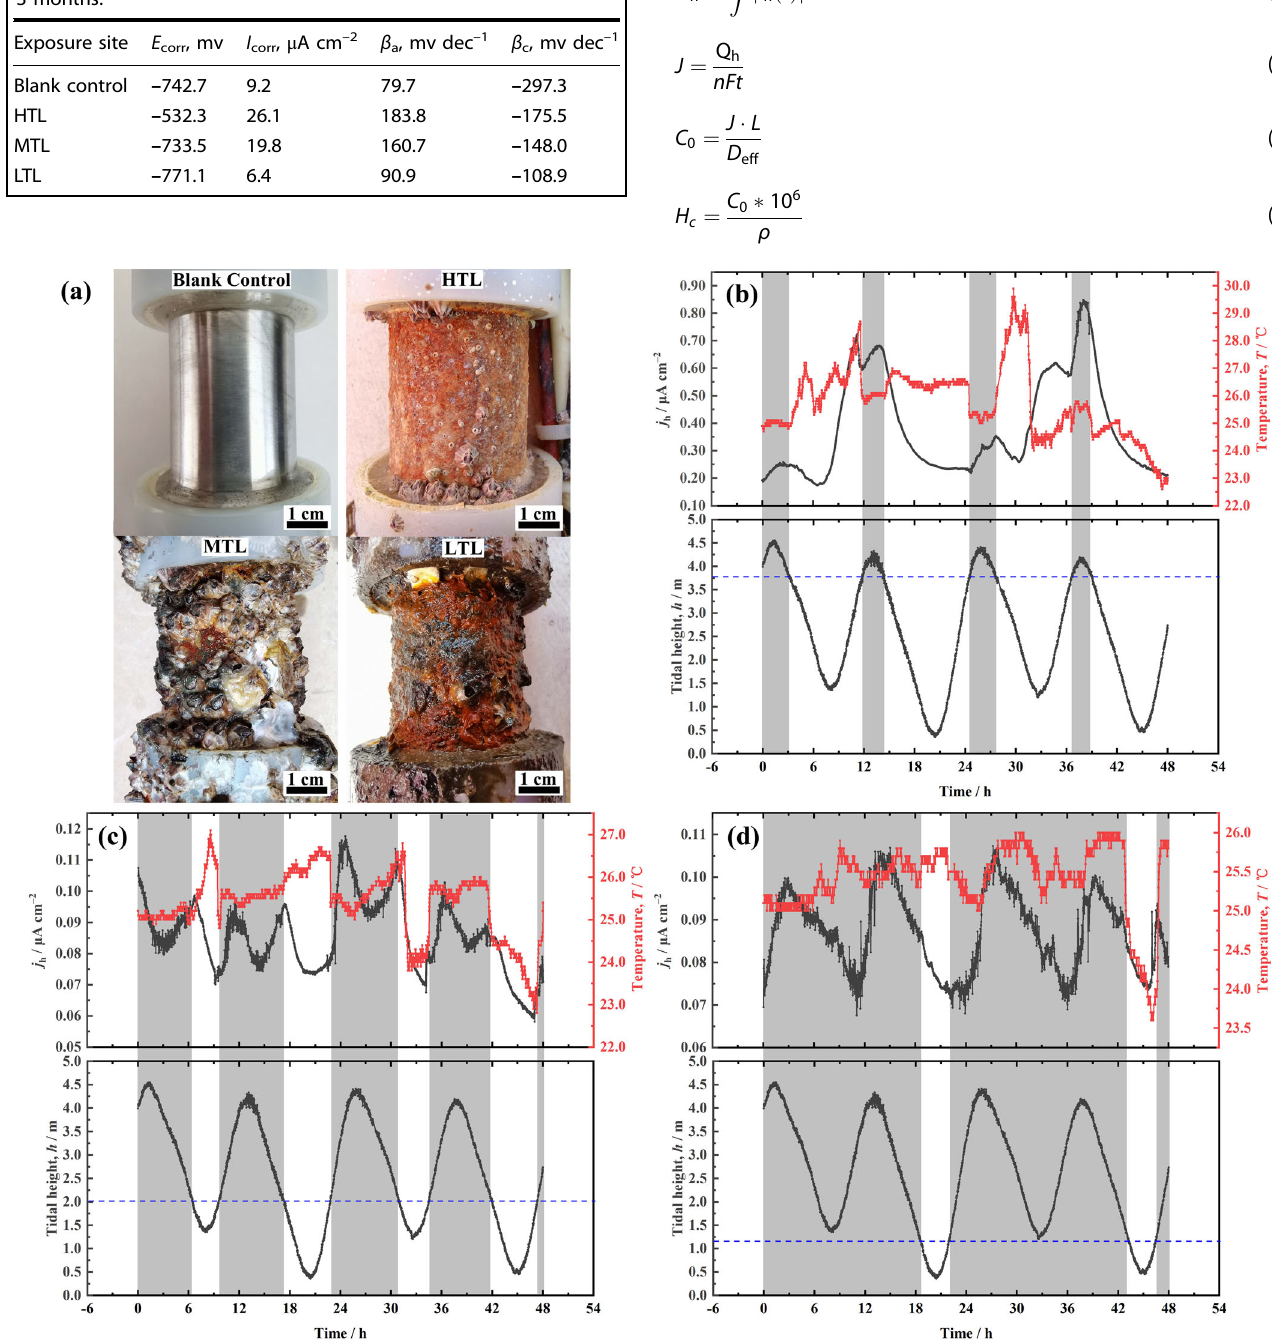
Fig. 8 Hydrogen permeation test results of the AISI 4135 steel samples during fi eld exposure. a Morphologies of the hydrogen permeation devices before and after fi eld exposure tests; variations in the ambient temperature and j h of the devices placed at the b HTL, c MTL and d LTL from 5 to 7 August 2020, including the tidal